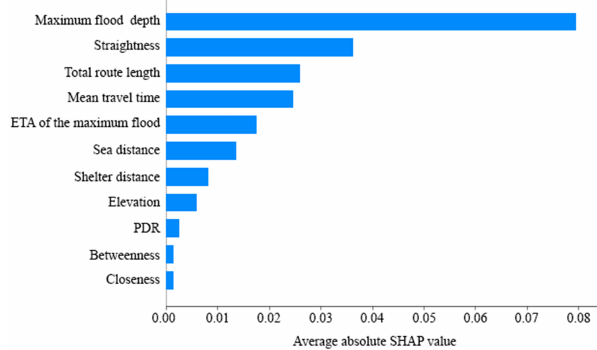
Figure 7. Average absolute SHAP values of the independent vari-